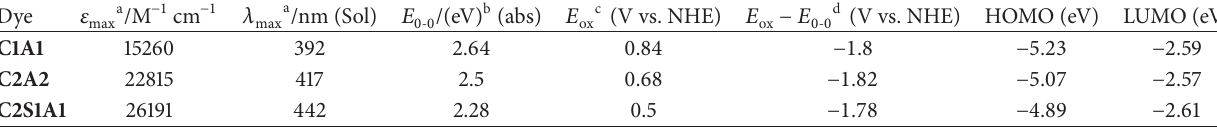
Table 1: Electrochemical parameters of organic dyes.